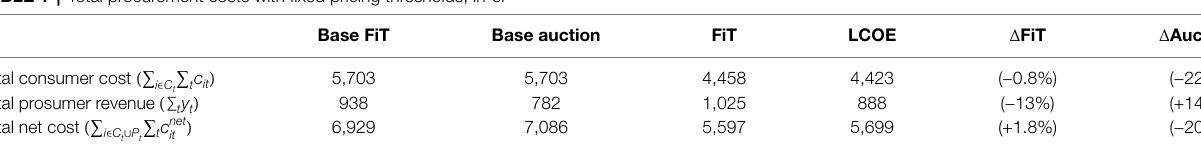
TABLE 1 | Total procurement costs with fixed pricing thresholds, in €.